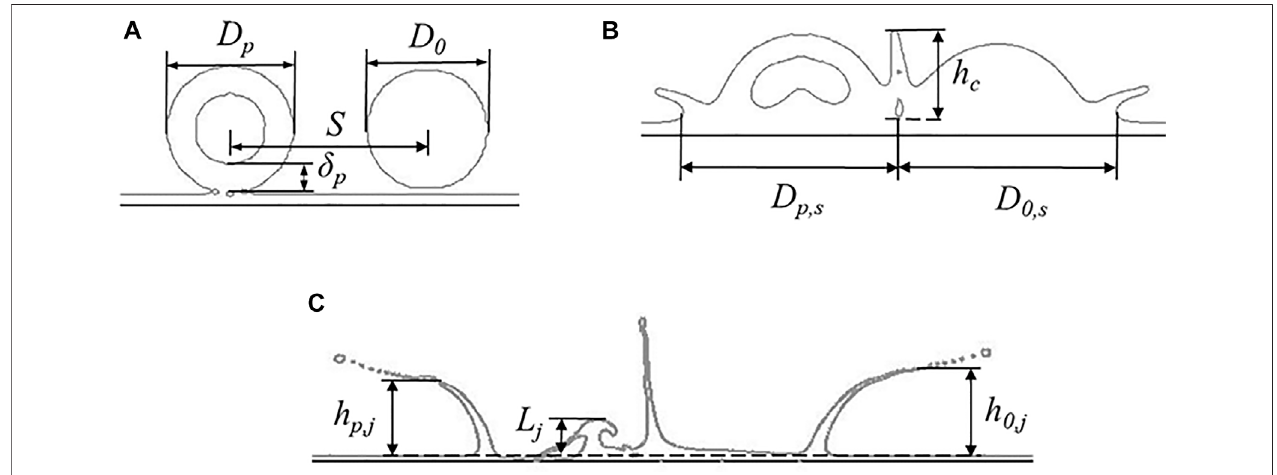
FIGURE 2 | Typical evolution stages in the impact of hollow droplet and continuous dense droplet on the liquid fi lm: (A) droplets contact with liquid fi lm, (B) central jet between droplets, and (C) counter jet inside the hollow droplet.